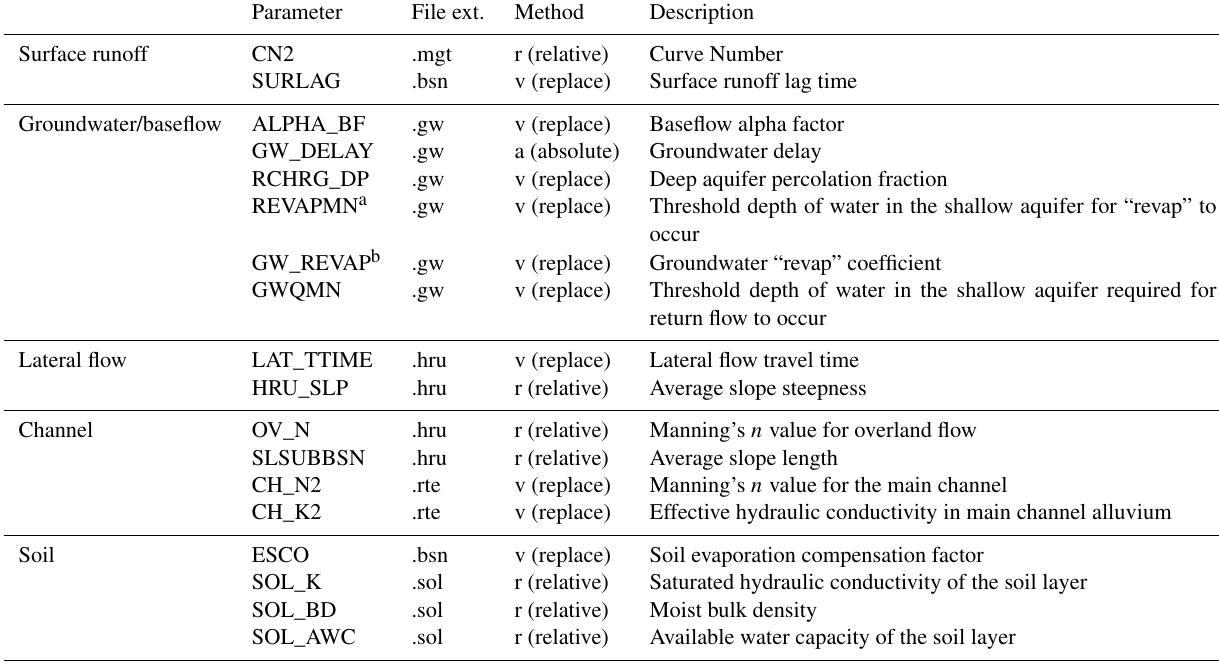
Table 3. Daily and subdaily SWAT-calibrated parameters. The method “r” indicates that the parameter value is multiplied by (1 + a given value), the method “v” indicates that the parameter value is going to be replaced, and the method “a” indicates that the parameter is to be added by a given value (Abbaspour et al., 2007).